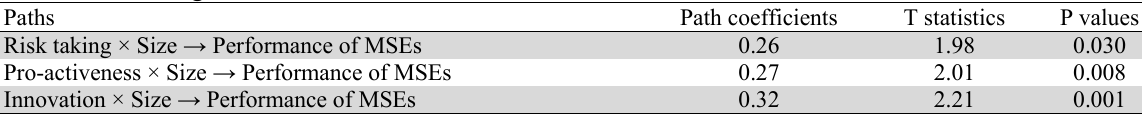
Moderation testing Paths Path coefficients T statistics P values Risk taking × Size → Performance of MSEs 0.26 1.98 0.030 Pro-activeness × Size → Performance of MSEs 0.27 Innovation × Size → Performance of MSEs